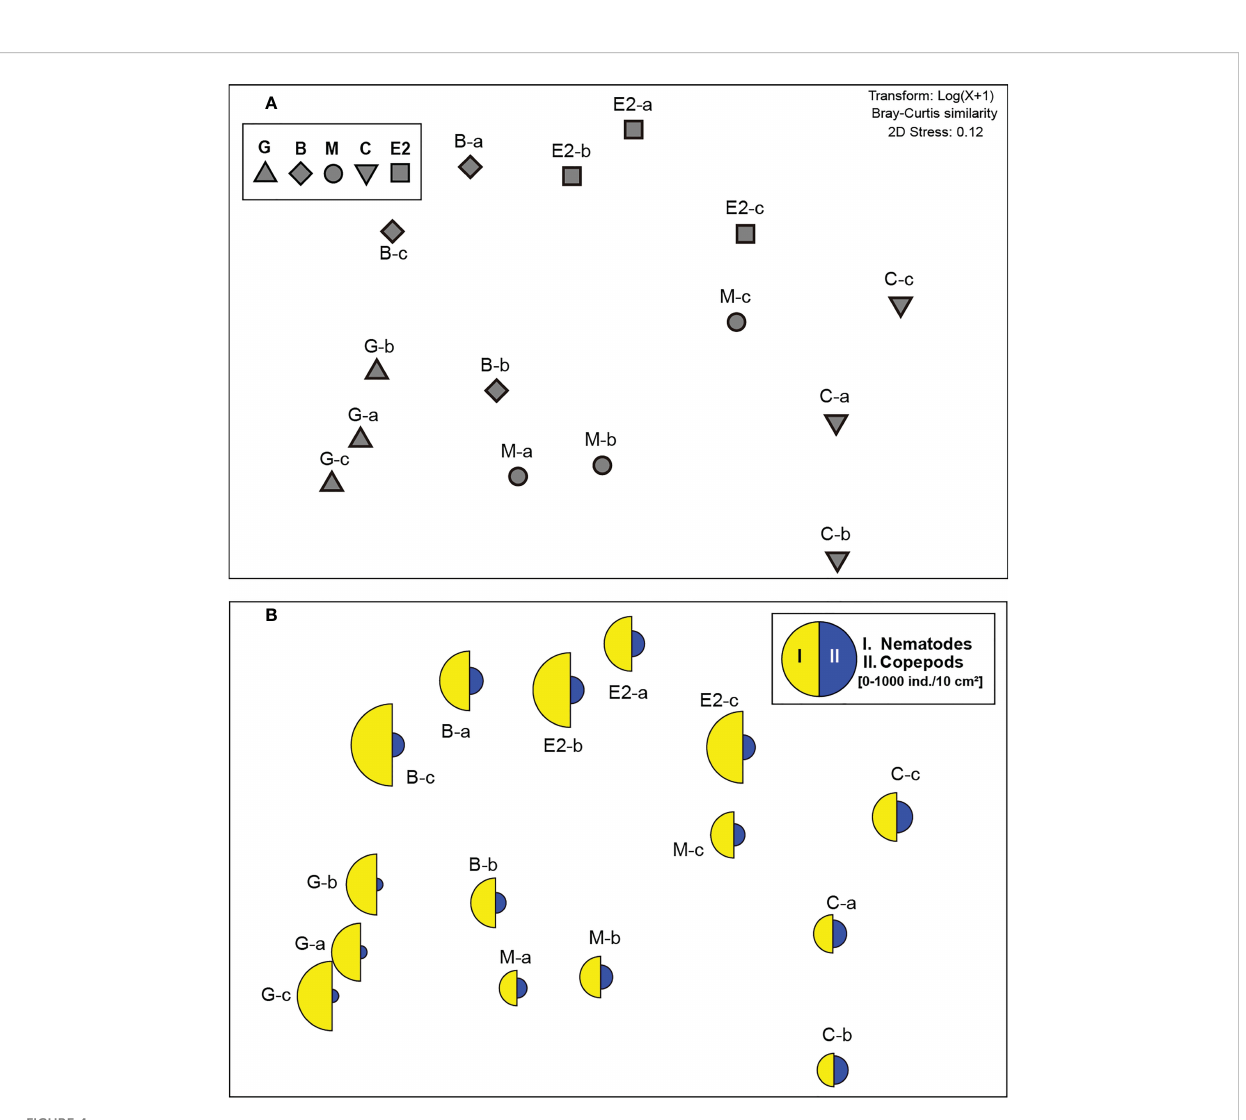
FIGURE 4 Two-dimensional non-metric multidimensional scaling (nMDS) ordination of meiofaunal communities (0 – 3 cm sediment depth) at higher taxonomic level in samples from the southeastern Bering Sea. (A) Ordination of single core samples (a – c) from stations G, B, M, C, and E2. (B) Superimposed segmented bubble plot for taxa that mainly contributed to the mean similarity in meiofaunal community structure within each station (detected by SIMPER analysis: I. Nematodes, II.